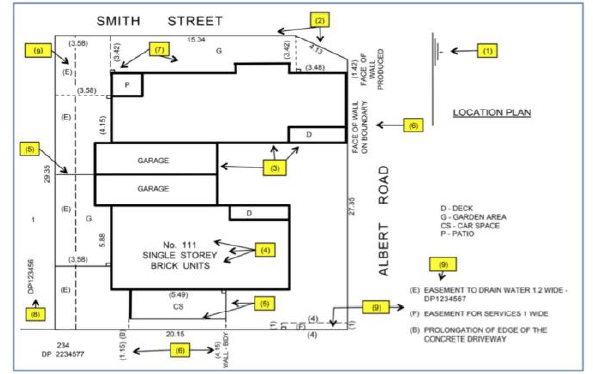
Figure 1: Location Plan (NSW LRS, 2021)